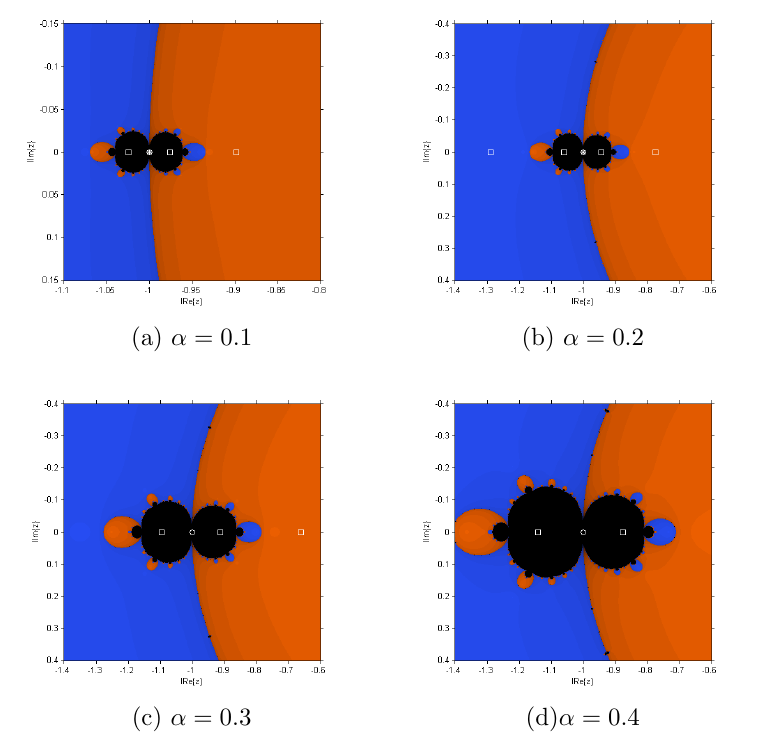
Figure 9. Zoom of different dynamical planes for small values of